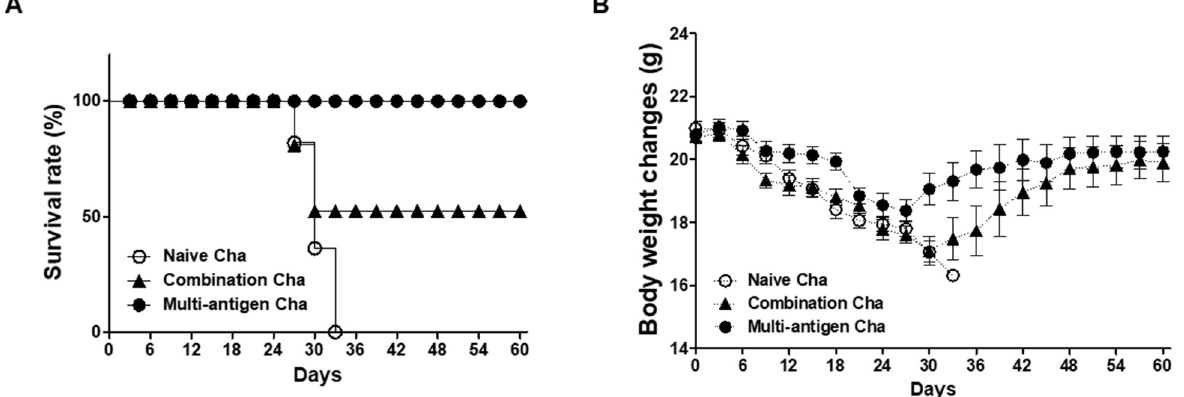
Fig 8. Protection induced by multi-antigen VLPs. All mice survived in multi-antigen immunized mice (Multi-antigen Cha, 100% of survival) whereas na ï ve mice showed 0% of survival and combination VLPs showed 50% of survival (A). Mice immunized with multi-antigen VLPs showed significantly lower body weight loss compared to na ï ve mice or combination VLPs